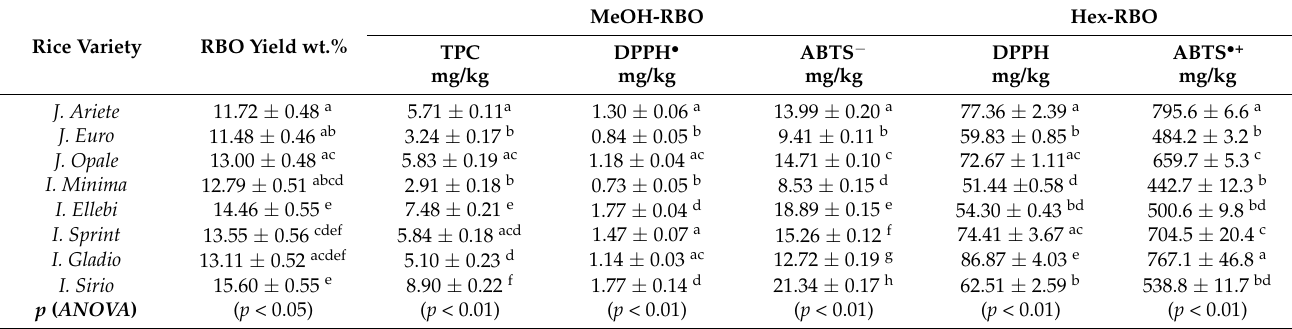
Table 2. Overall extraction yield of RBO obtained by supercritical CO 2 extraction for the different varieties and antioxi- dant activities of MeOH- and Hex-RBO. TPC-Total phenolic content; DPPH-DPPH • scavenging activity; ABTS − ABTS • + scavenging activity, with ( ±